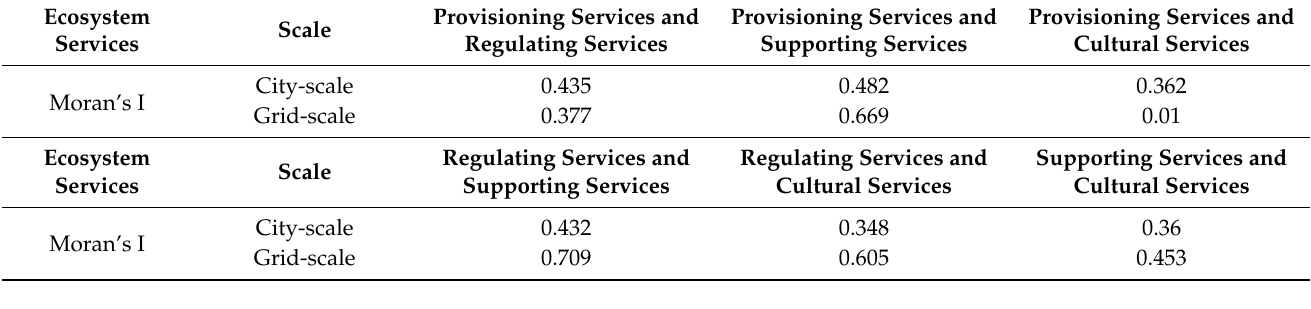
Table 6. Global spatial autocorrelation of four ecosystem services in Sichuan Province.